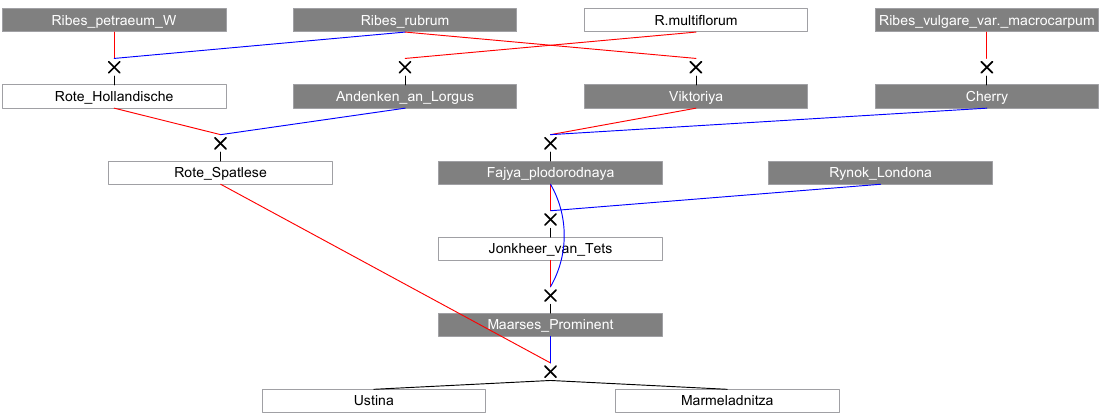
Figure 2. The pedigree of the cultivars Ustina and Marmeladnitza (in the white rectangle, the genotypes that are present in the analysis, in the gray-that are absent in the analysis, the red line is maternal, the blue line is paternal). The Figure is built using the Pedimap 1.2 software (© Plant